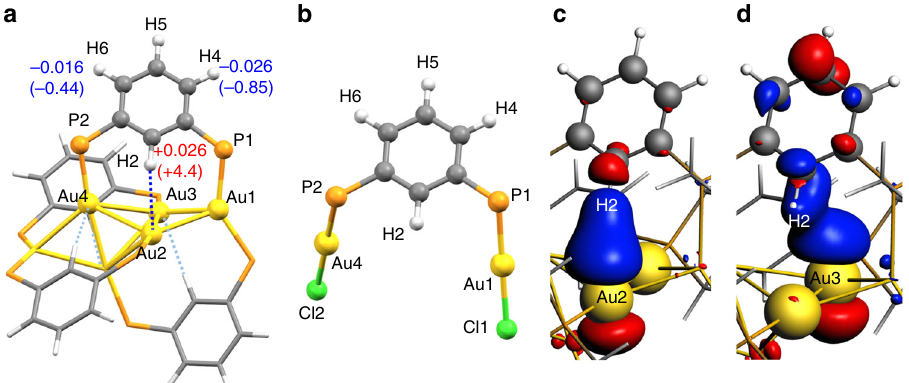
Fig. 1 Schematic structures of 1 and 2 , and selected ETS-NOCV channels in 1 . a The schematic structure of 1 with indicated differences in calculated charges and experimental 1 H NMR shifts 4 (in brackets) between 1 and 2 for selected hydrogens. b Precursor 2 . ETS-NOCV channels in 1 ′ corresponding to c Au2···H2 – C2 interaction, and d side-on Au3···H2 – C2 interaction. Large P(Ph) 2 sidechains are omitted for clarity. Cutoff of 0.0002 is used in c and d